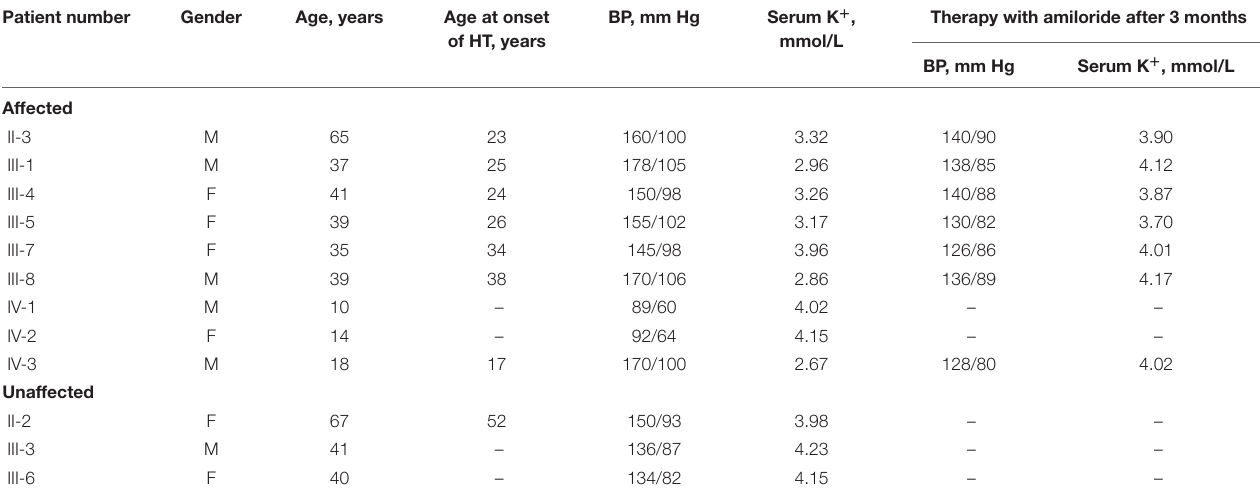
TABLE 2 | Clinical data of family members involved in this